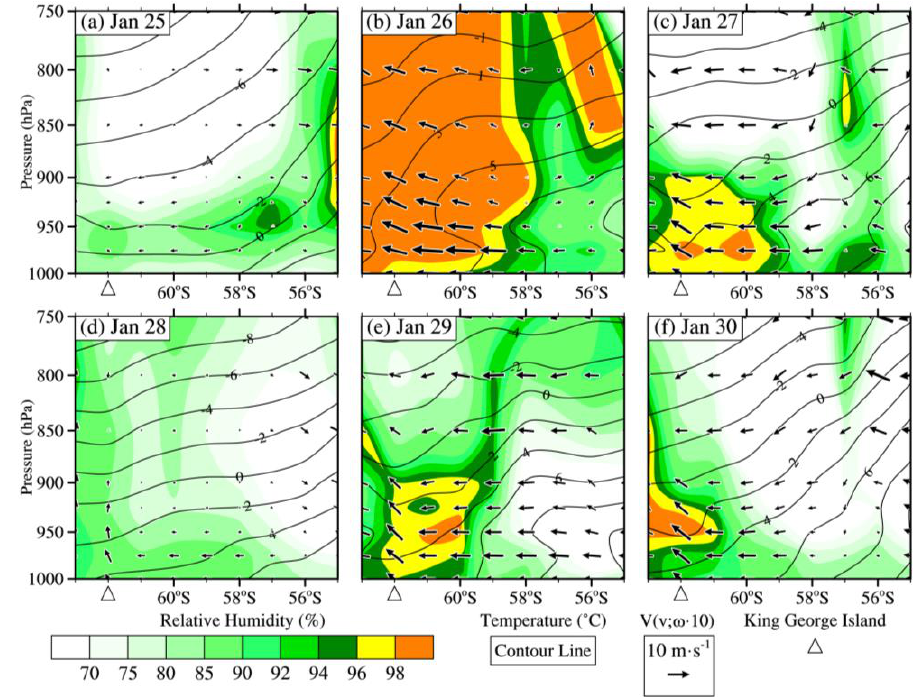
Figure 7. Vertical section of relative humidity (shading), temperature (contour), and the composite of the v-component of wind in m · s − 1 and 10 times the vertical velocity in Pa · s − 1 (vector) along the longitude line of 301 ◦ E, from latitude 55 ◦ S to 63 ◦ S, across King George Island at a pressure level below 750 hPa, at 0600 UTC from 25 January to 30 January 2017 ( a – f ). The triangles indicate the location of King George Island.